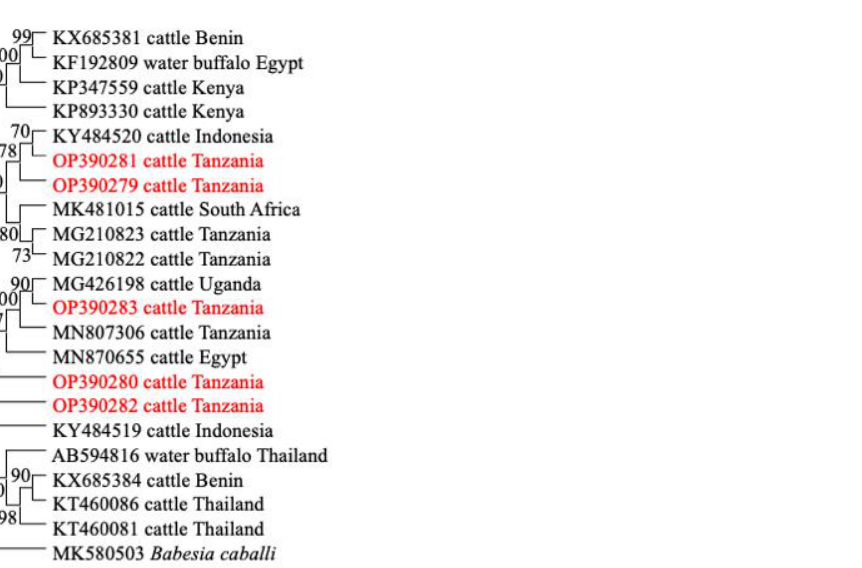
Figure 2. The phylogenetic analysis of Theileria parva identified in this study, based on the ( p104) gene sequences. The tree was constructed by MEGA version 11 using the maximum likelihood method. The numbers at nodes represent the percentage occurrence of the clade in 1000 bootstrap replications of the data. Sequences from this study are shown in red. Theileria lestoquardi (KT989594) was used as an outgroup.